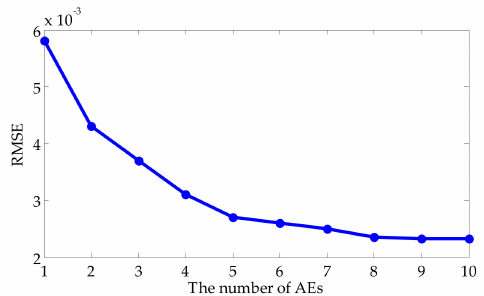
Figure 8. The relationship between the number of AEs and the RMSE